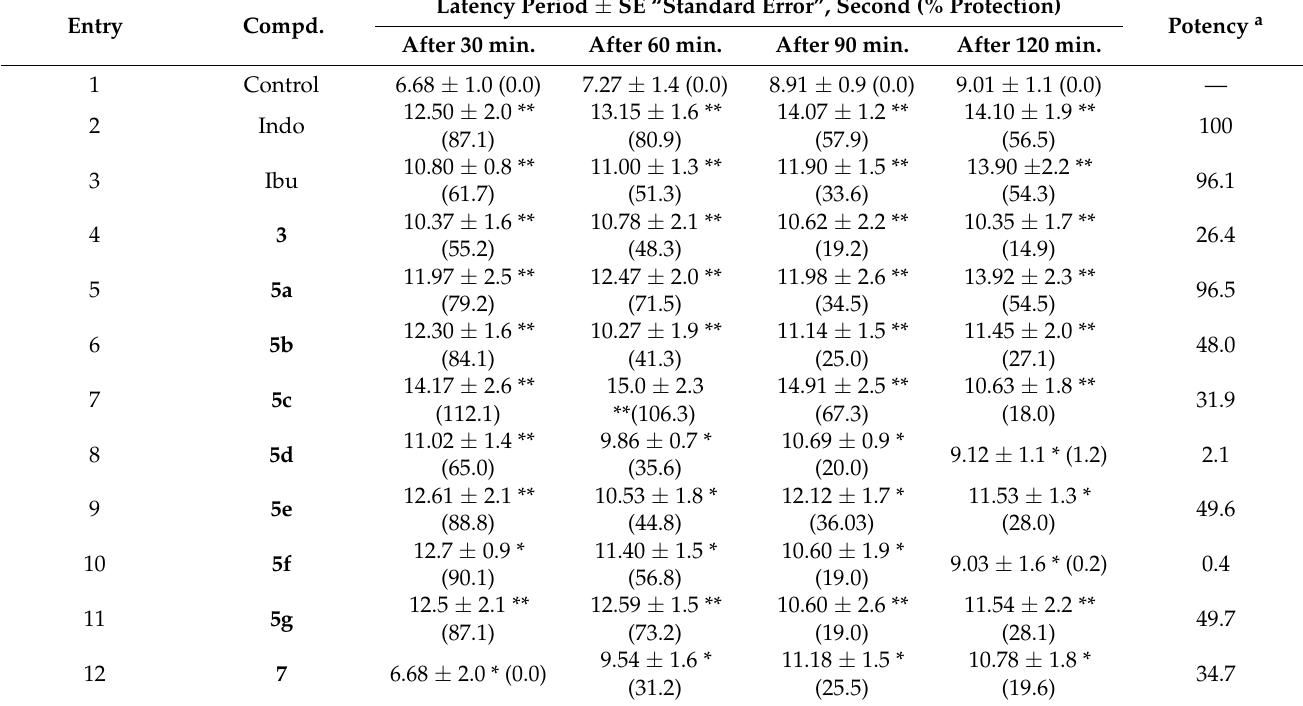
Table 3. Central analgesic properties of the prepared